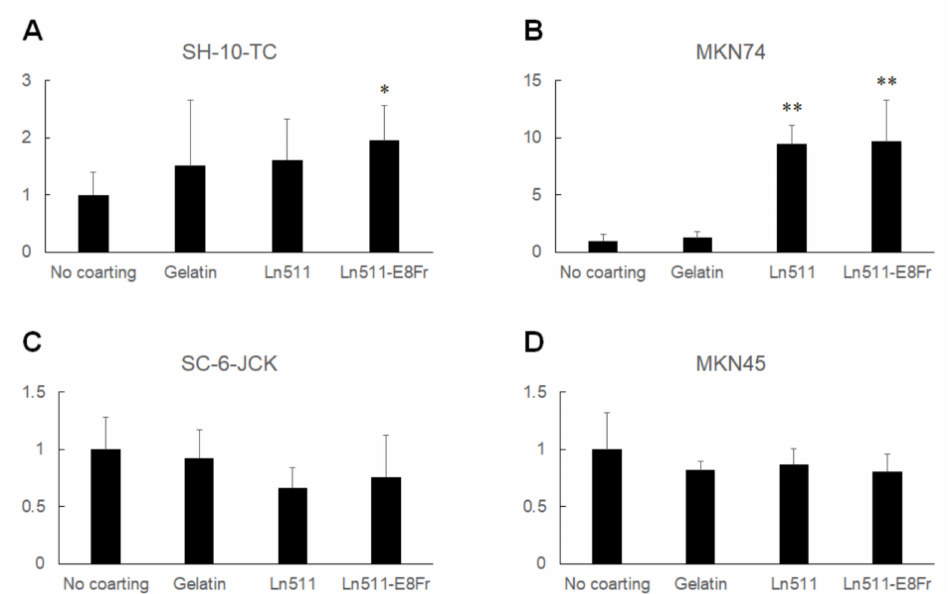
Figure 5. Difference in gastric cancer cell areas between the coating materials. Although the cytoplasm of SH-10-TC was larger on gelatin-, Ln511-, and Ln511-E8 fragment-coated plates than the control (no coating), the difference was not statistically significant for cells cultured on gelatin and Ln511, which might be due to the large standard deviation ( A ). The cell areas of MKN74 were apparently larger on the Ln511 and Ln511-E8 fragments than those of the control (no coating) ( B ). No differences in the sizes of the SC-6-JCK ( C ) and MKN45 cells ( D ) were observed. * p < 0.05, ** p < 0.01, as indicated (vs. no coating). Values are normalized to those of controls (no coating) and data are presented as mean ± standard deviation of five representative